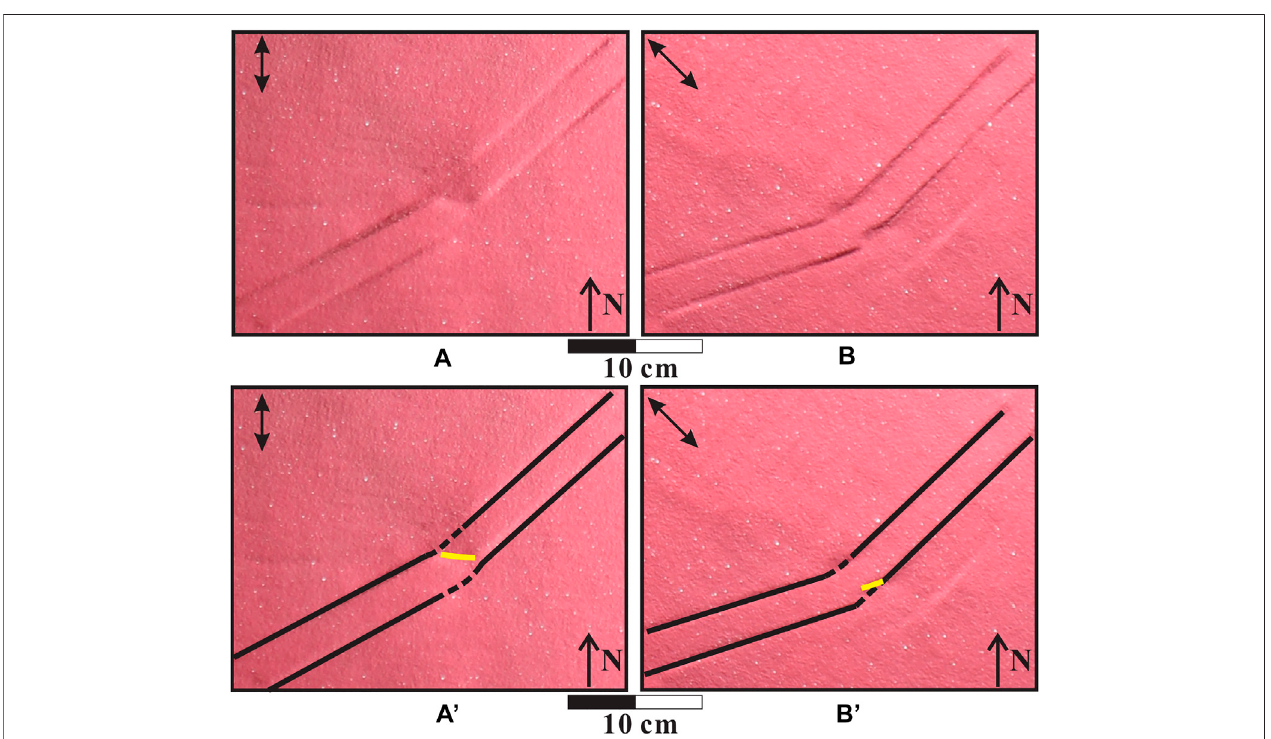
FIGURE13| ModelingresultsofSeriesIIexperiments. (A) AnE-W-strikingfaultisformedatthetransferzoneoftheNE-SW-strikingpre-existingfaultsunderaN-S stressdirection. (B) AsmallNE-SW-strikingfaultisformedatthetailoftheNE-SW-strikingpre-existingfaultsunderaNW-SEstressdirection.Thefaultsareshownin (A ’ ) and (B ’ ) ,wheretheblacklinesdenotepre-existingfaults,theblackdottedlinesdenotethearcextensionofpre-existingfaults,andtheyellowlinesdenotethenewfaults.